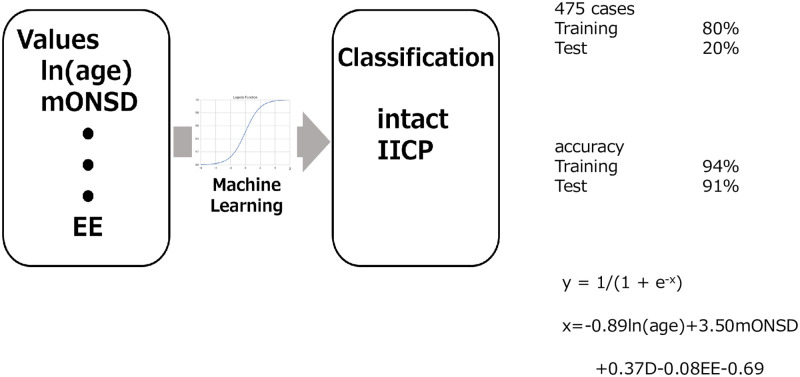
Schematic figure of supervised machine learning and the results, showing accuracy of machine learning application was 94% for training, and 91% for test.Also it shows the logistic equation obtained, y = 1/(1+e-x), x = -0.89ln(age)+3.50mONSD+0.37D-0.08EE-0.69.